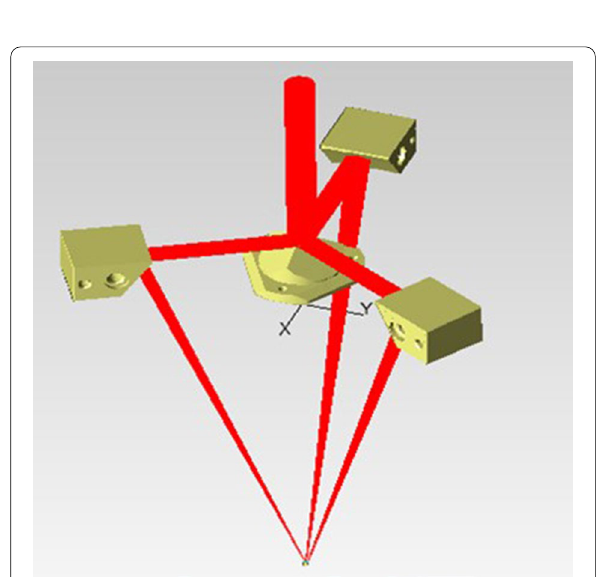
Figure 7 3D model of lens system and transmission of three-beam laser